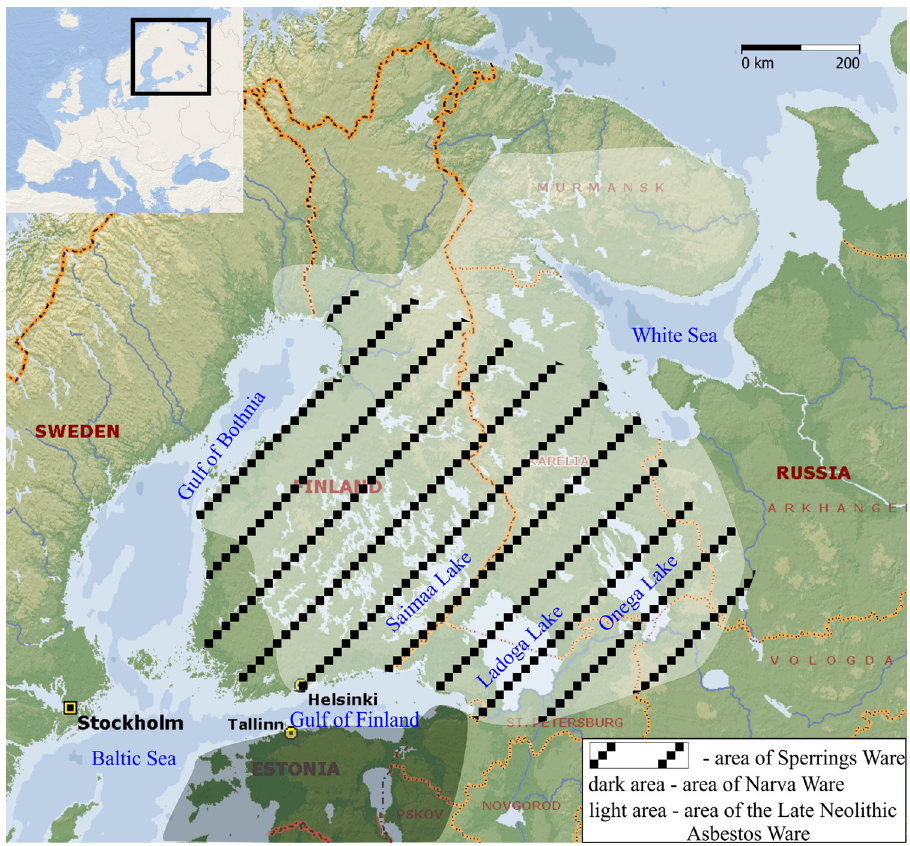
Figure 1: Map of the study area and neighboring